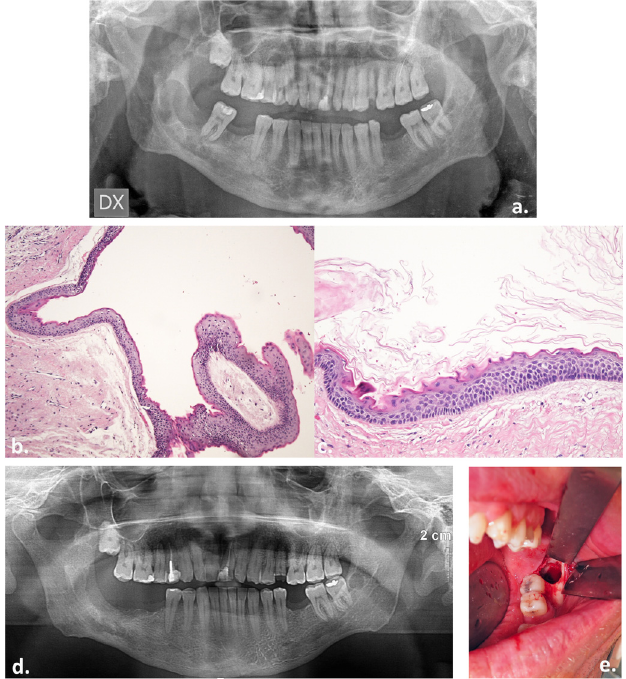
Fig. 1. Case presentation of a patient affected by multiple presentation of OKCs: (a) radiological presentation of OKC next to the tooth 4.7; (b,c) hematoxylin and eosin staining of enucleated OKC, (d) presentation of the 2nd OKC after 12 months next to the tooth 3.8; (e) surgical management of OKC with enucleation and Carnoy ’ s solution